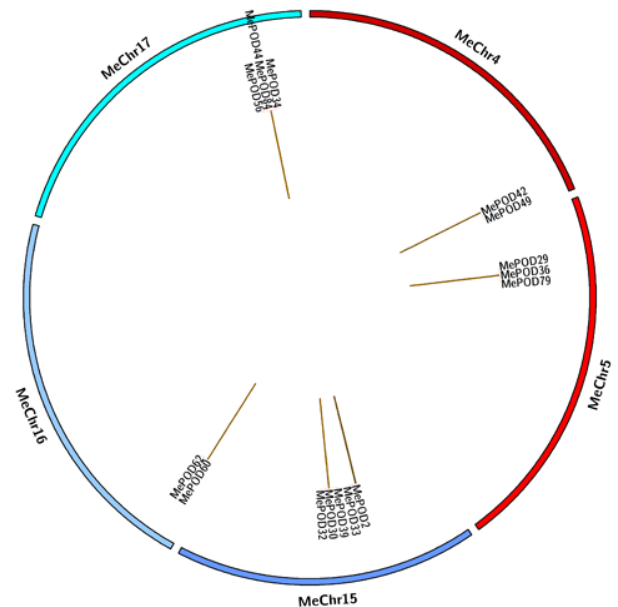
Figure 5. Analyses of POD gene duplication in cassava. The program Circos (Canada’s Michael Smith Genome Sciences Center, Vancouver, Canada) was used to draw different chromosomes in a circular distribution. The brown connection lines represent tandem duplication events of POD genes in cassava.